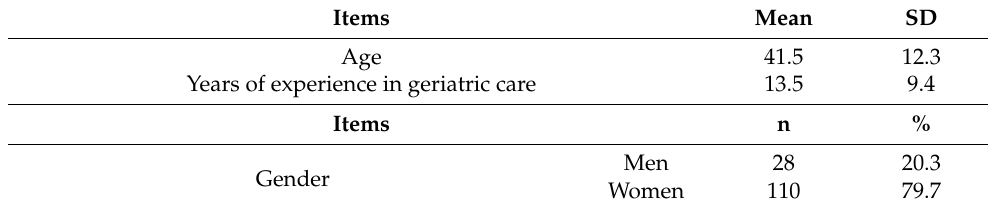
Table 1. Participants’